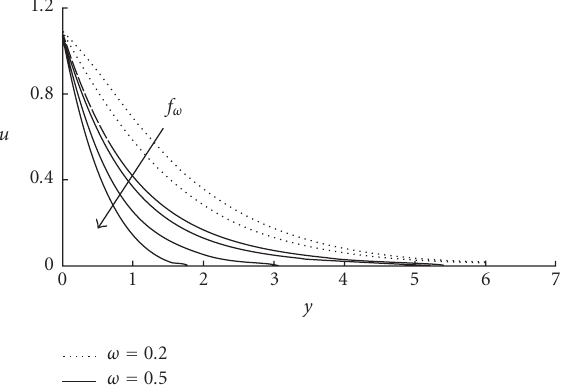
Figure 5.1. E ff ect of surface mass transfer on velocity distribution, where f ω = 3 . 0,1 . 0,0 . 0, − 1, − 2, − 3.